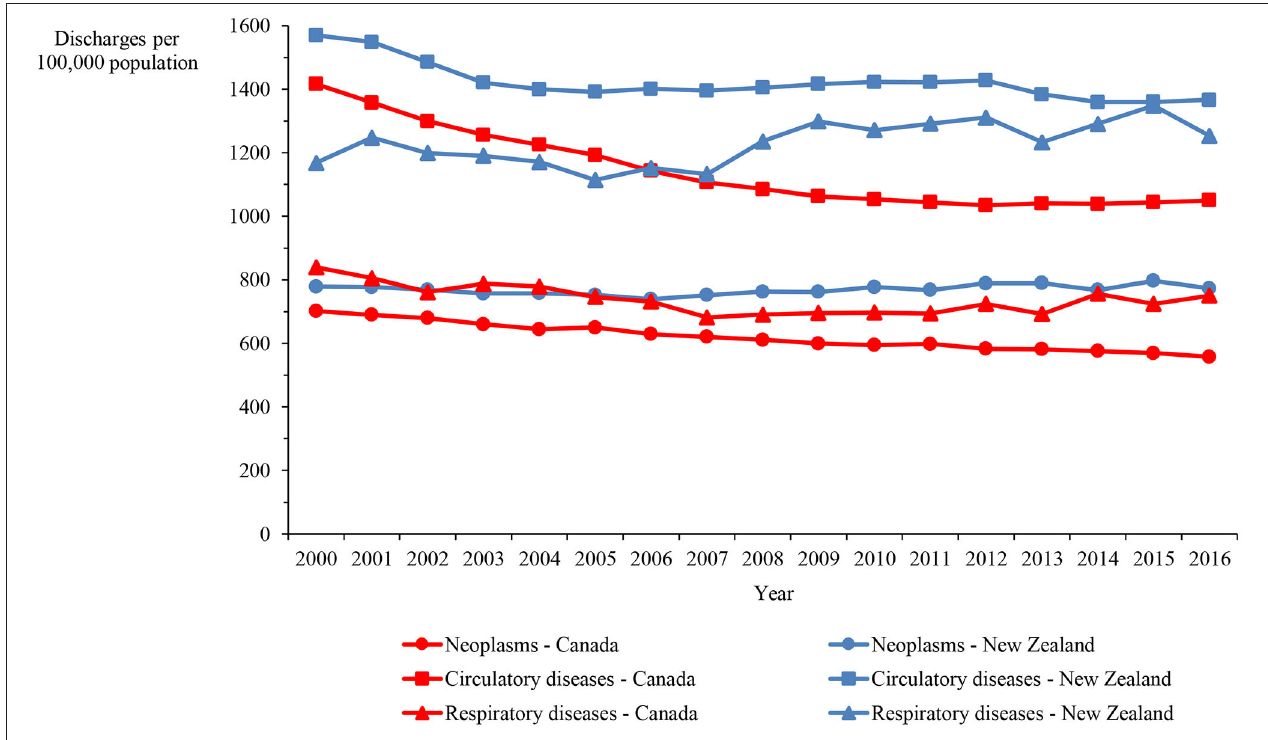
FIGURE 1 | Hospital discharge rate in Canada and New Zealand for neoplasms and circulatory and respiratory diseases,